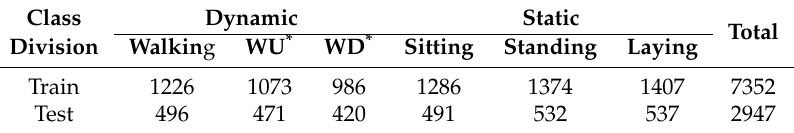
Table 2. Activity class constitution and number of samples in UCI HAR dataset.